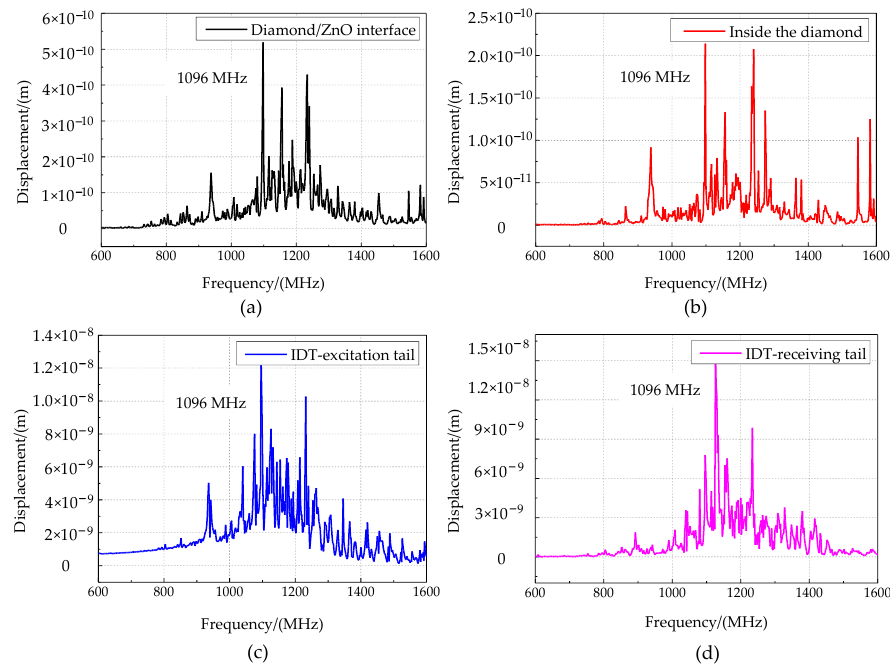
Figure 8. Relationship between displacement and frequency of the phonon piezoelectric device. ( a ) Diamond–ZnO interface; ( b ) inside the diamond; ( c ) IDT excitation tail; ( d ) IDT receiving tail.